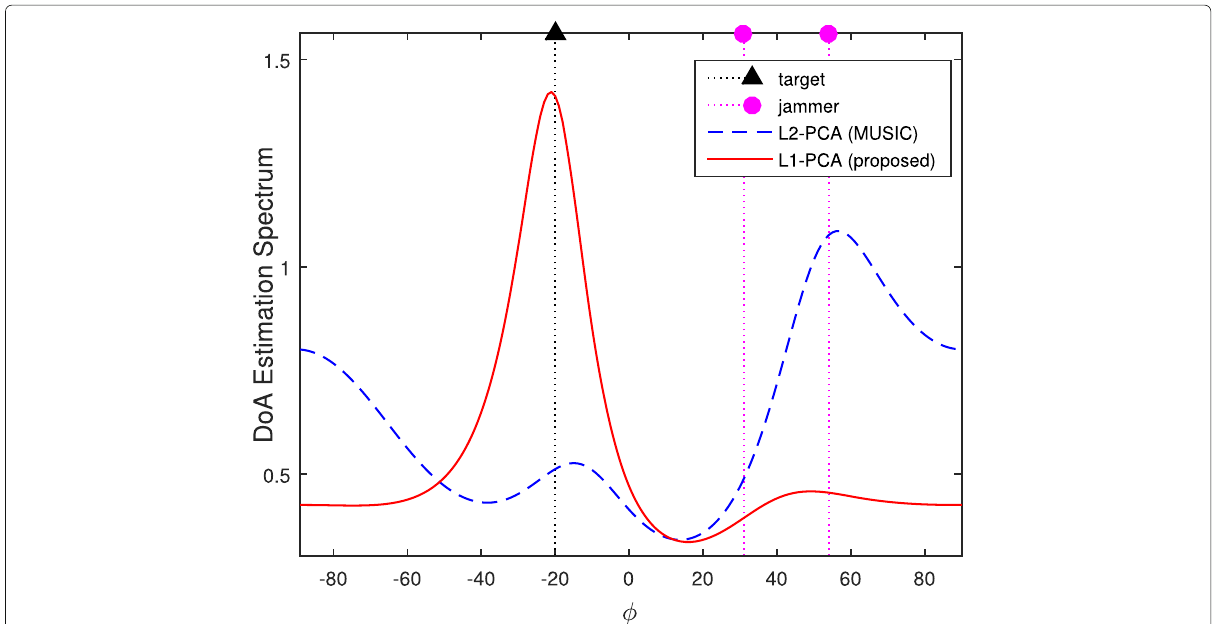
Fig. 5 DoA-estimation spectra P R (φ ; Q R , L 2 ) (MUSIC) and P R (φ ; Q R , L 2 ) (proposed); one target and two jamming signals with angles of arrival marked by (cid:3) and • , • ,